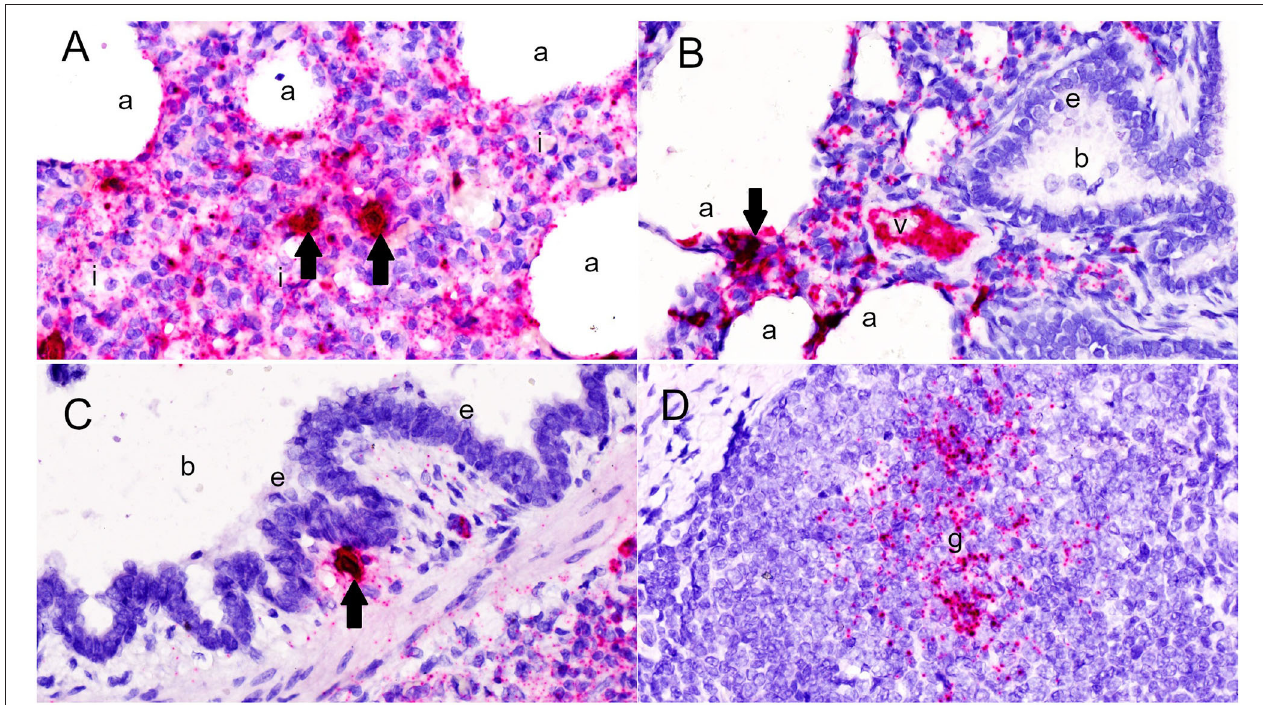
FIGURE 2 | Detection of porcine parvovirus 2 (PPV2) nucleic acid in the lungs by in situ hybridization (ISH, × 600). (A,B) The ISH signals of PPV2 were detected as pinpoints in the cytoplasm of monocytic cells expanding the alveolar interstitium ( i ), as well as pneumonocytes and alveolar macrophages lining the alveoli ( a ) and endothelial cells lining the small blood vessels ( v ). (C) Intensive intracytoplasmic and intranuclear signals of PPV2 were detected in large cells resembling macrophages or dendritic cells ( arrows ). PPV2 signals were also detected in round cells around the bronchus ( b ), but not the bronchial epithelium ( e ). (D) Aggregation of the PPV2 ISH signals in the germinal center ( g ) of the lymphoid follicle in peribronchial lymphoid